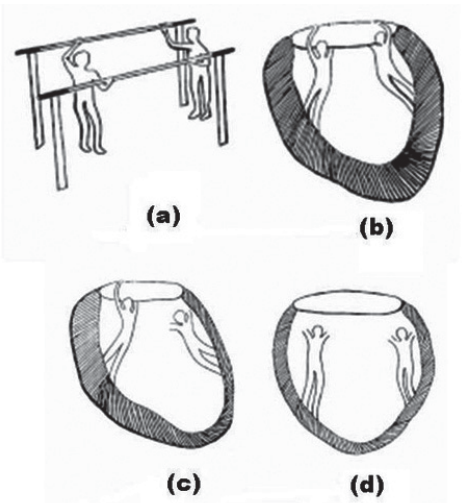
Fig. 7 – (a) As barras paralelas correspondem ao anel mitral; (b) Os braços dos ginastas são as cordas tendíneas e os músculos papilares são os corpos. O solo é a parede do ventrículo esquerdo; (c) Ressecção parcial de cordas; (d) Ressecção completa de cordas. Efeito da ressecção de cordas – Notar a dilatação e o afilamento nos locais onde as cordas foram ressecadas parcial ou completamente. (Reproduced from: Kumar AS. Ind J Thorac Cardiovasc Surg